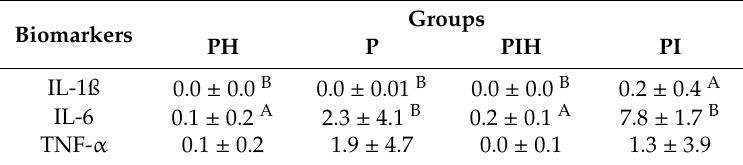
Table 3. Mean mRNA levels ( ± SD) for all biomarkers